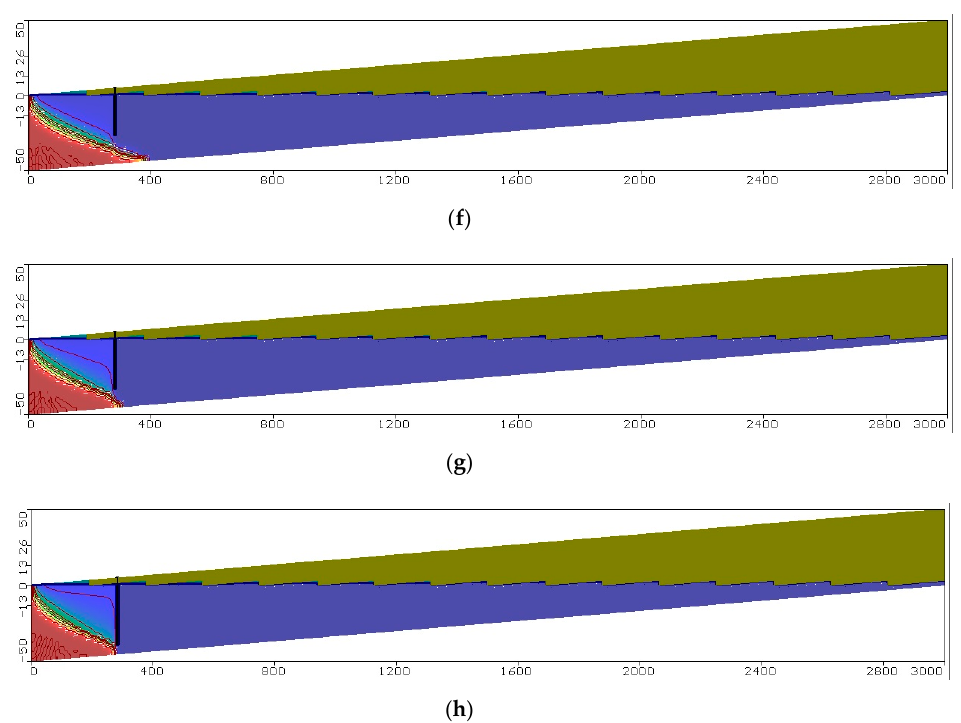
Figure A4. Saltwater distribution (in mg / L) in the Akrotiri aquifer for ( a ) the steady state and embedded barrier wall with X b / L o = 0.6 and ( b ) d b / d = 0.2, ( c ) d b / d = 0.3, ( d ) d b / d = 0.4, ( e ) d b / d = 0.5, ( f ) d b / d = 0.6, ( g ) d b / d = 0.7 and ( h ) d b / d = 0.8.